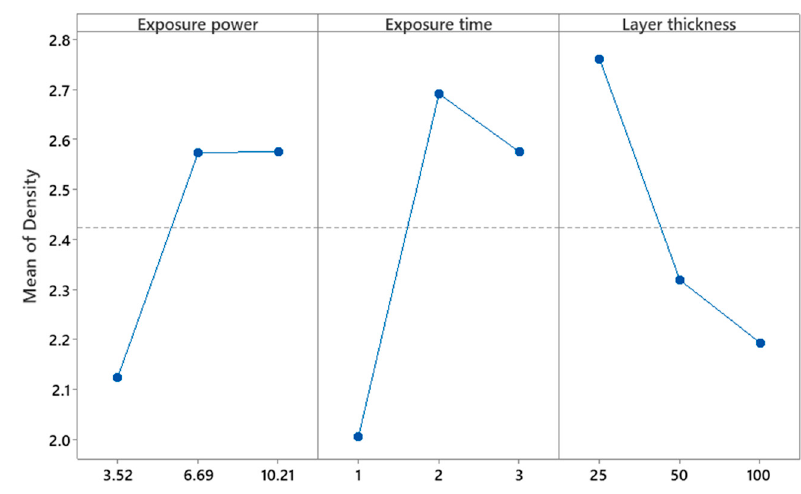
Figure 13. Effect of the process parameters on the mean of the density.